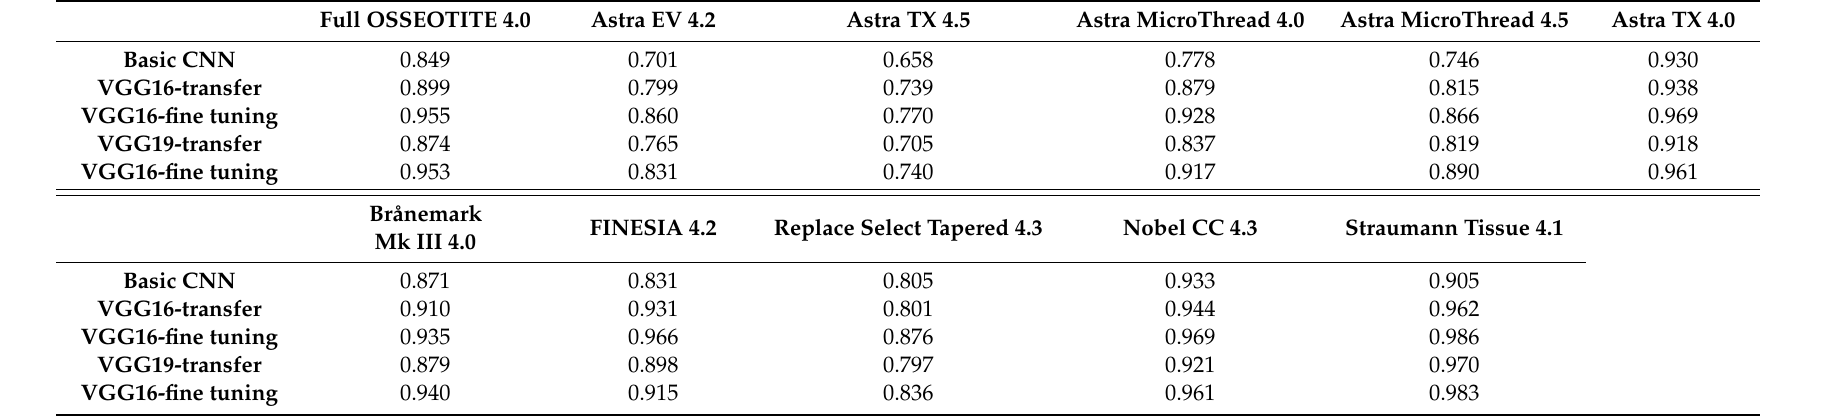
Table 3. Dental implant classification performance by F 1 score.